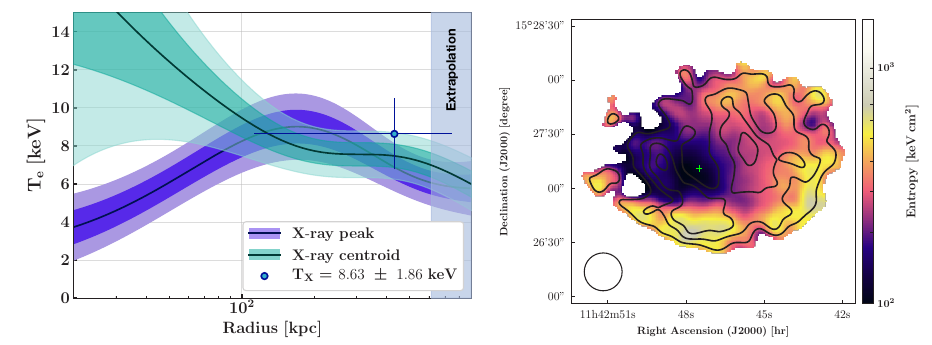
Figure 2. Density (left) and pressure (right) profiles of MOOJ1142 + 1527 estimated by considering the X-ray peak Figure 3. Left: Temperature profiles obtained by combining the Chandra density profiles and the NIKA2 pressure (purple) or the X-ray centroid (green) in the deprojection procedure based on the Chandra and NIKA2 data. The profiles. We also show the single spectroscopic temperature measurement from the Chandra data. The color code dark and light colored regions around the best-fit profiles give the 68% and 95% confidence levels. The light grey is the same as in Fig. 2. Right: Entropy map of MOOJ1142 + 1527 obtained from the combination of the ICM rectangles show the region where the models are extrapolated but not constrained by the data. Figure extracted from pressure and density maps estimated using the NIKA2 and Chandra surface brightness maps shown in Fig. 1. The [14]. green cross shows the location of the X-ray peak. Figure extracted from